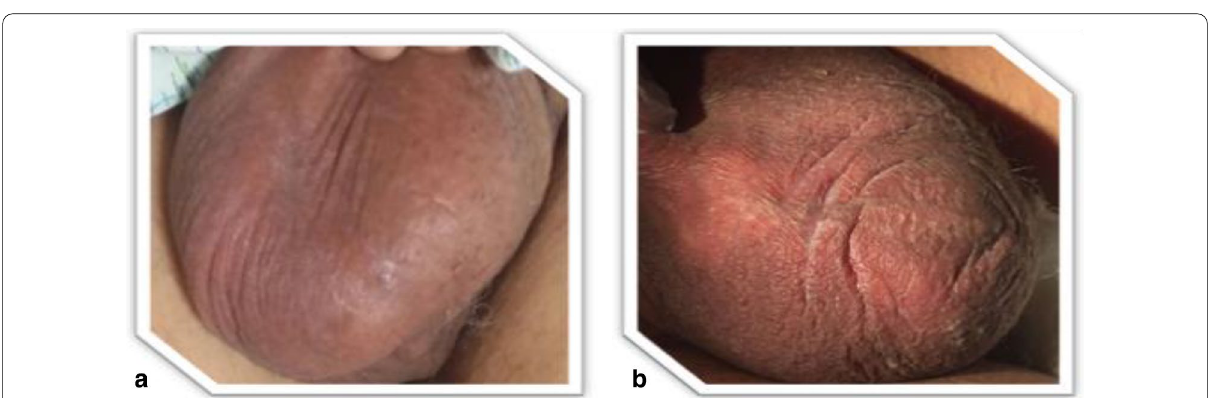
Fig. 2 Redness and edema of the scrotal wall before ( a ) and after ( b ) the anti-brucellosis